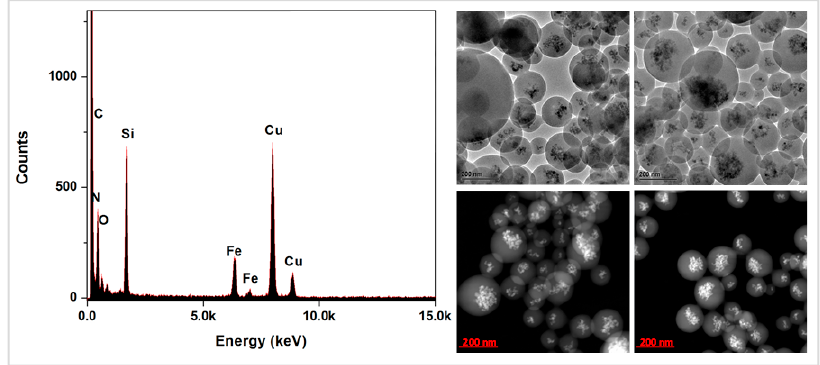
Figure 5. Energy-dispersive X-ray analysis (EDX) ( left ) and TEM-STEM ( right ) analysis of magnetic chiral PMO nanoparticles.